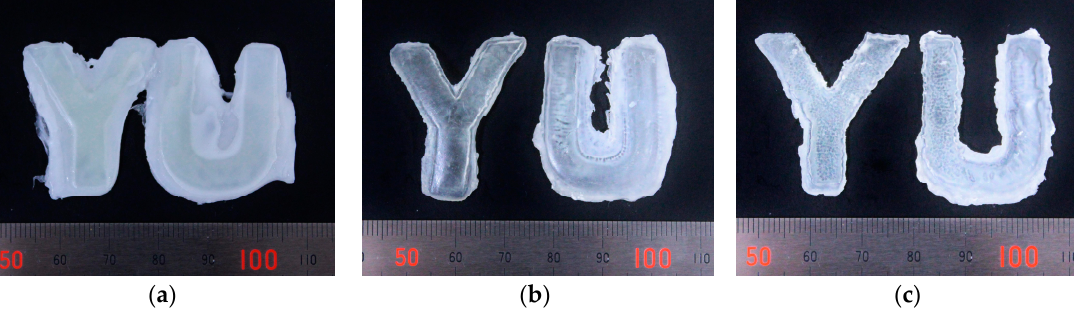
Figure 5. Characters “YU” printed on LumiForge under the same condition with different molar ratios of SA to DMAA at 0.50:1.00 (3DP 0.50) ( a ), 0.33:1.00 (3DP 0.33) ( b ) and 0.25:1.00 (3DP 0.25) ( c ). The printing performances improved with the decreasing molar fraction of SA.